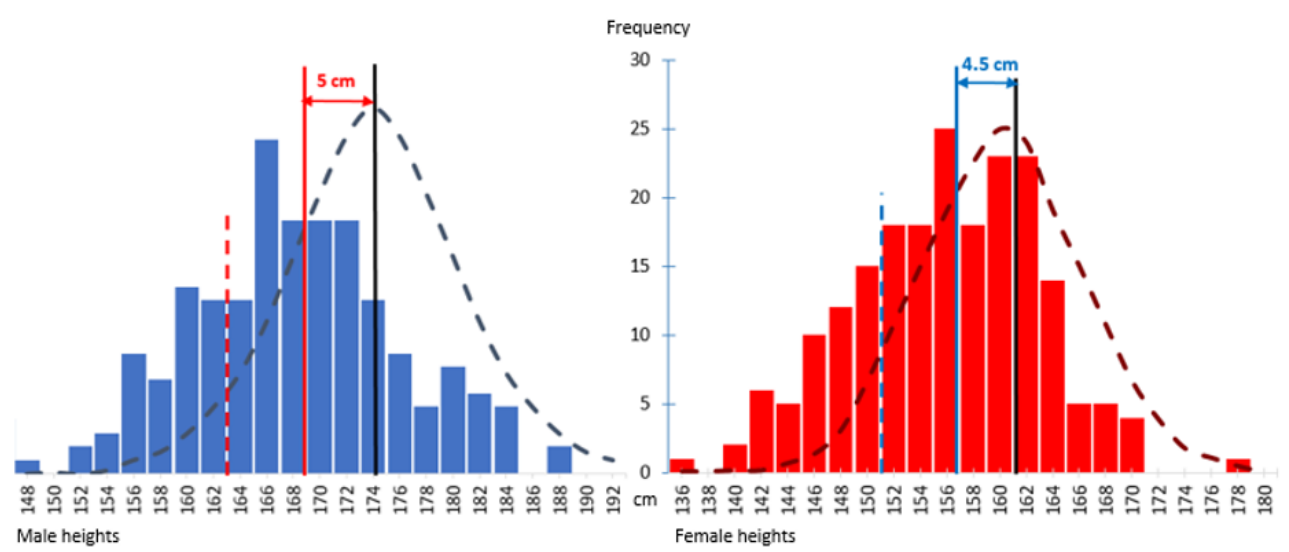
Figure 2. The histogram on the left (blue bars) shows a normal distribution for adult heights of 192 male 22q11.2DS participants, with a mean (red vertical line) of 169.0 ± 7.8 cm, and on the right the histogram (red bars) similarly shows a normal distribution for adult heights of 205 female 22q11.2DS participants, with mean (blue vertical line) 156.7 ± 7.1 cm. The superimposed male (mean 174.1 ± 7.3 cm) and female (mean 161.2 ± 6.2 cm) Canadian population adult height normal curves for males and females are shown, respectively, by long dashed dark blue and dark red lines. Both historgrams show a leftward shift of approximately 5.0 and 4.5 cm for males and females with 22q11.2DS, respectively. Bars to the left of the dashed red/blue vertical lines indicate those meeting criteria for short stature for males and females, respectively. Table 1. Clinical and demographic factors for adults with 22q11.2 deletion syndrome for the subgroup of n = 314 with known 22q11.2 deletion